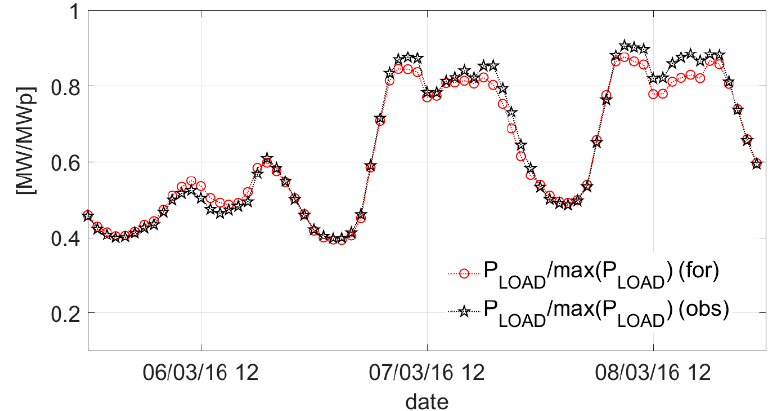
Figure 12. Observed and predicted load profiles of three consecutive days (North zone).